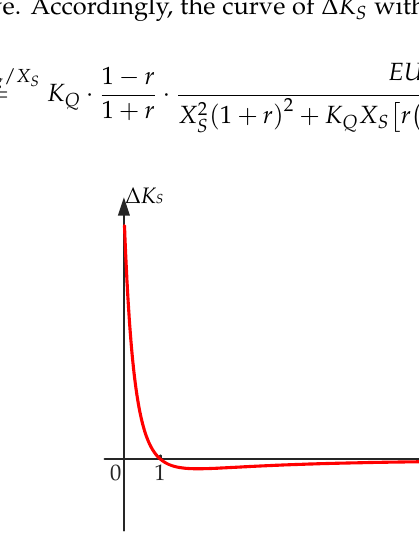
Figure 6. Curve of Δ K S with respect to the ratio X g / X S . Figure 6. Curve of ∆ K S with respect to the ratio X g / X S